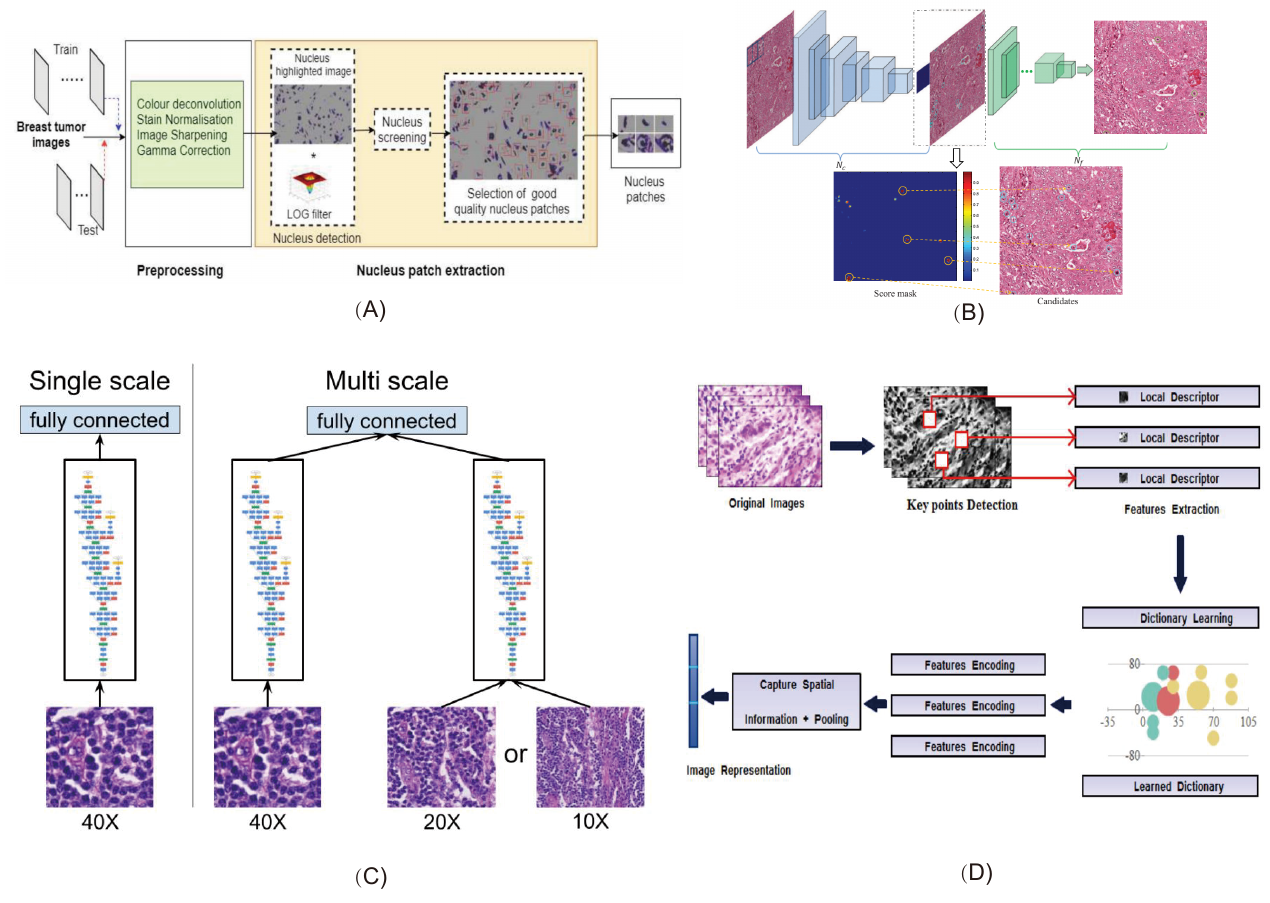
Figure 3. Some typical models of breast lesion detection methods. ( A ) The network structure and model reported by George et al. ( B ) The network reported by Chen et al. The deep cascaded convolutional neural network was used to achieve high accuracy while greatly increasing the speed of analysis. (Reproduced with permission from [Hao Chen], [THIRTIETH AAAI CONFERENCE